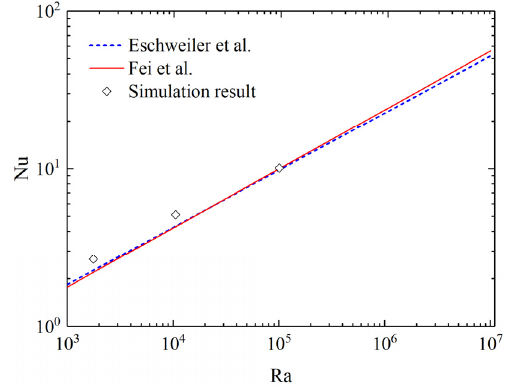
Figure 6. Model validation.